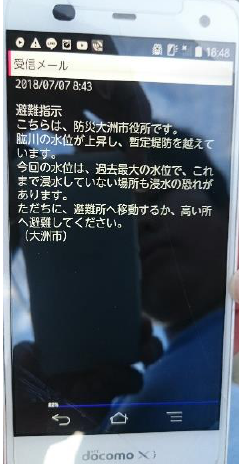
Figure 7. PWS on a mobile phone (Ozu) .